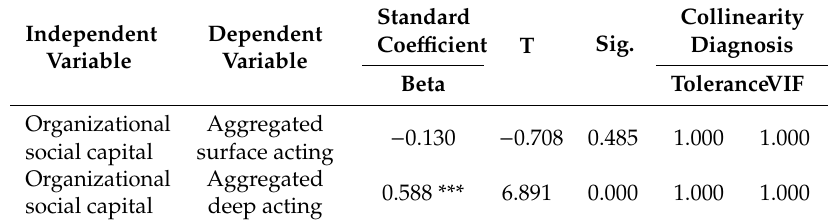
Table 11. Regression analysis of organizational social capital and aggregated emotional